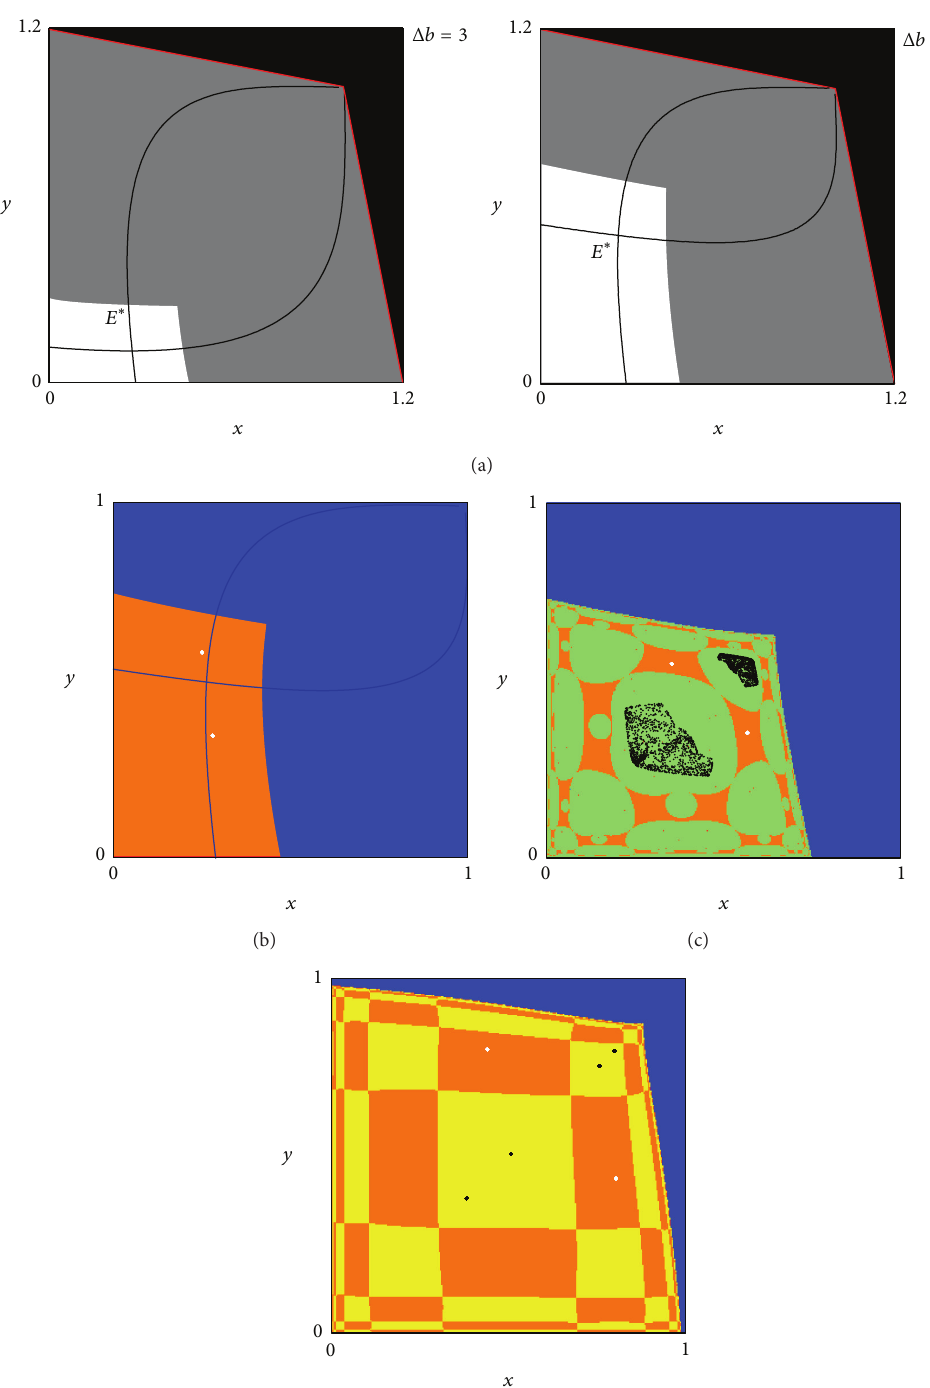
Figure 6: (a) Parameter values: 𝛼 = 1.5 , 𝑤 = 0.5 , 𝑏 = 5.1 , and 𝑑 = −0.2 . The Nash equilibrium for positive and negative values of Δ𝑏 . (b) If Δ𝑏 = −0.3 , the Nash equilibrium is unstable and a 2 -period cycle is globally stable. (c) A complex attractor 𝐴 (black points) coexists with a 2 -period cycle (white points) if 𝛼 = 1.5 , 𝑤 = 0.5 , 𝑏 = 2.07 , 𝑑 = −0.2 , and Δ𝑏 = 0.15 . (d) Coexisting attractors if 𝑏 = 0.2 , 𝑑 = 0 while Δ𝑏 = 0.01